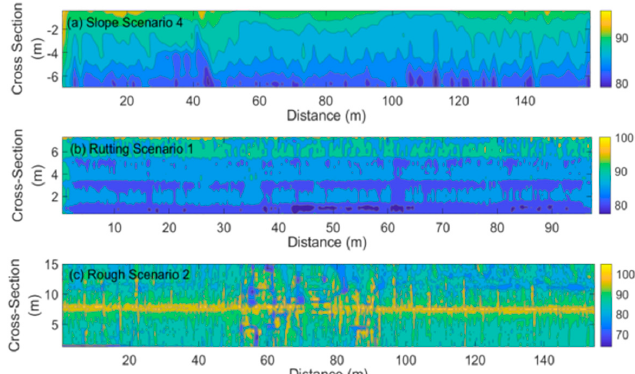
Figure 16. Hydroplaning Speed Estimation using the Gallaway model. ( a ). Hydroplaning speed distribution on the slope scenario 4; ( b ). Hydroplaning speed distribution on the rutting scenario 1; ( c ). Hydroplaning speed distribution on the rough scenario 2.